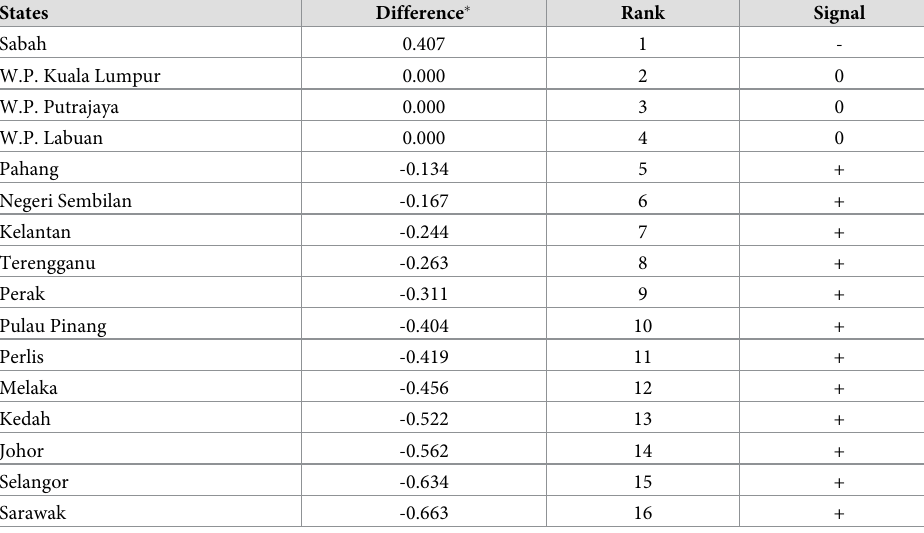
Table 5. COVID index comparison between 2020 and 2021.